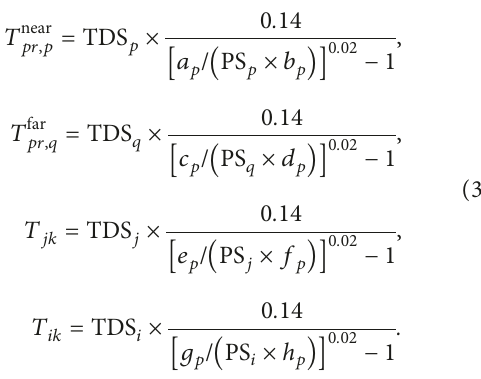
15: Independent runs for the 9-bus system by NLP